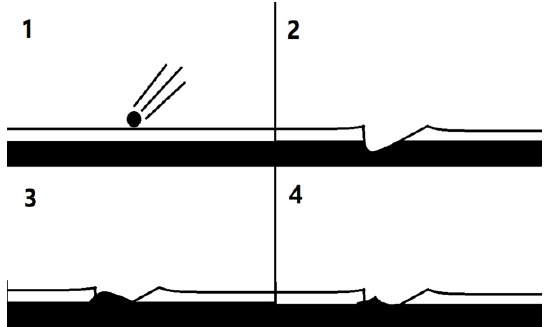
Figure 7. Schematic diagram of the different forming mechanism of the uplift part and the non-uplift part of the titanium content. The white and black parts in the figure are different strata, and their titanium content is different.